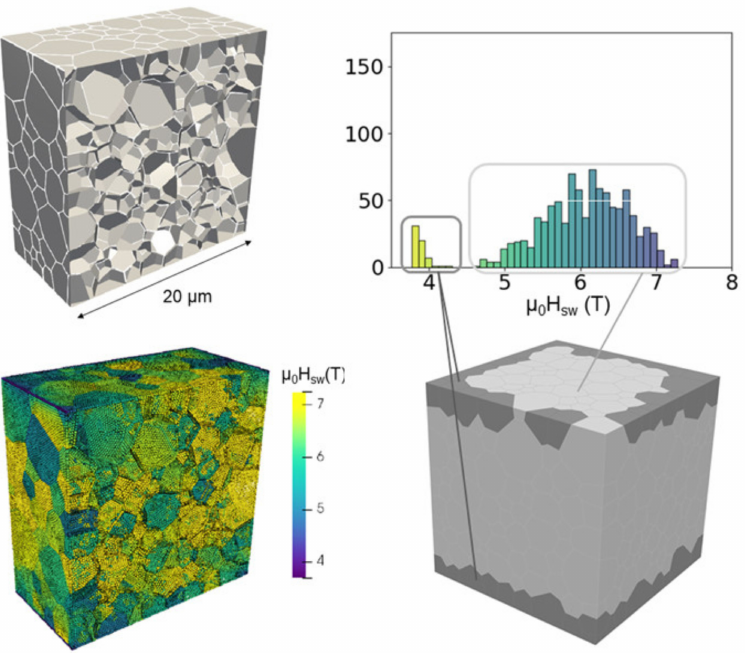
Figure 5. Representation of structure with identification of grain with lower switching fields (posi- tioned on the edges) [21]. This article is licensed under a Creative Commons Attribution 3.0 License (https://creativecommons.org/licenses/by/3.0/ accessed on 12 March